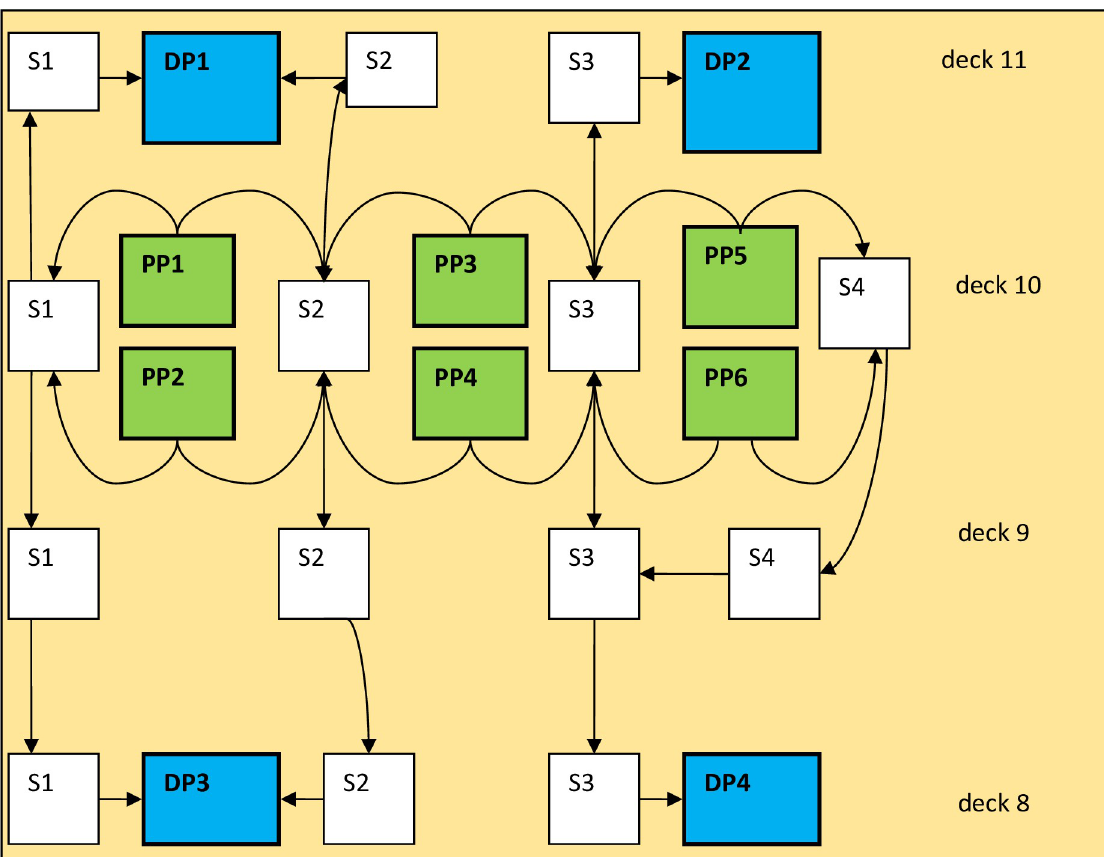
Fig 8. Schema of evacuation routes. (PP- initial, S-staircases, DP- destination